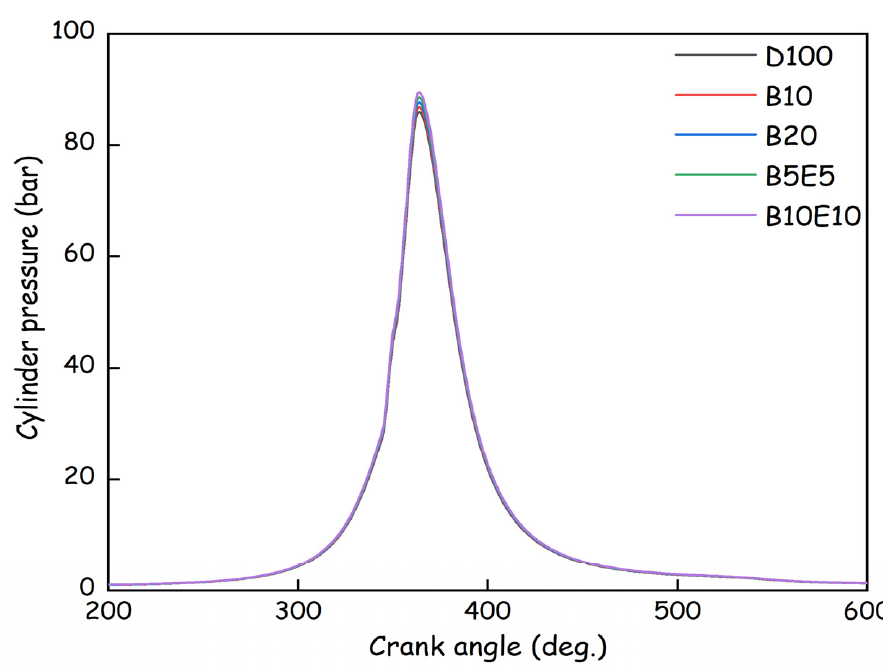
Figure 3. Cylinder pressure against engine load at full load.